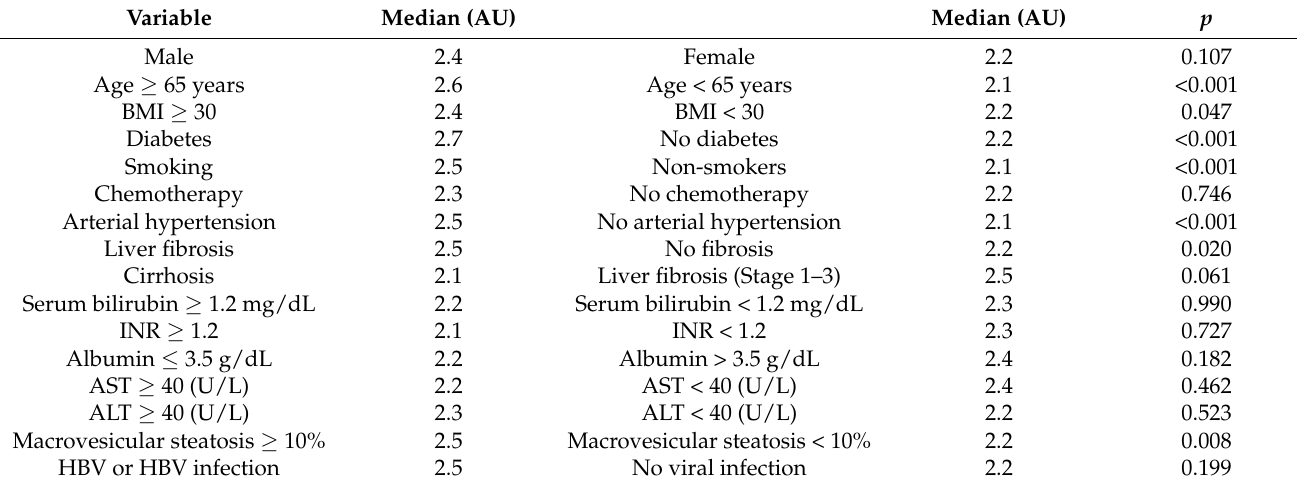
Table 3. Distribution of skin autofluorescence (SAF) among patient